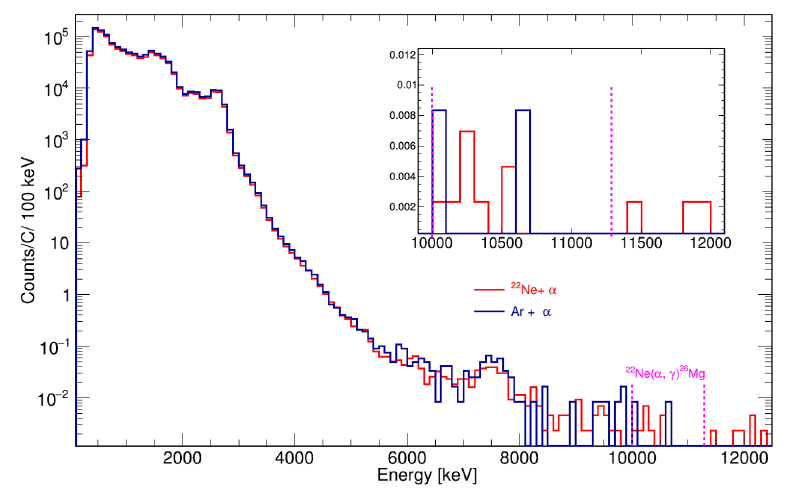
Figure 4: Addback mode spectra. In red the sum of all addback spectra in α + 22 Ne obtained during Campaign II. In blue the sum of the spectra in Ar used for the study of the beam induced background. The dashed magenta lines define the ROI for the 395 keV